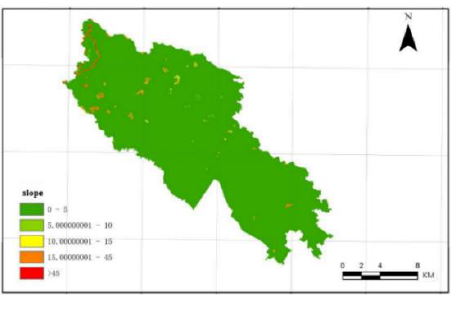
Figure 4 Pidu slope